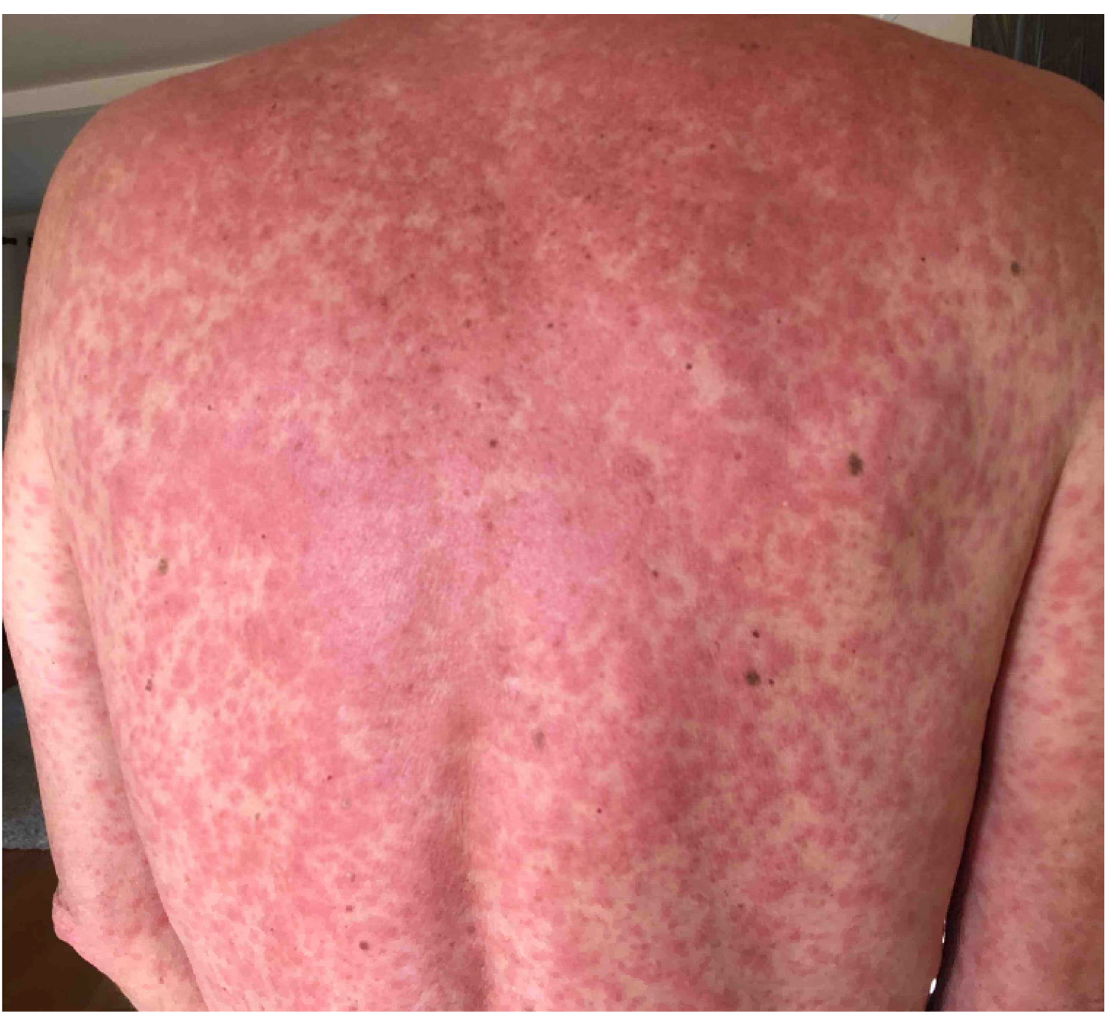
Figure 2. Patient with Bactrim DIHS. Morbilliform rash with 50% body surface area (BSA) involvement. Table 2. Case of Bactrim DIHS. M—male.